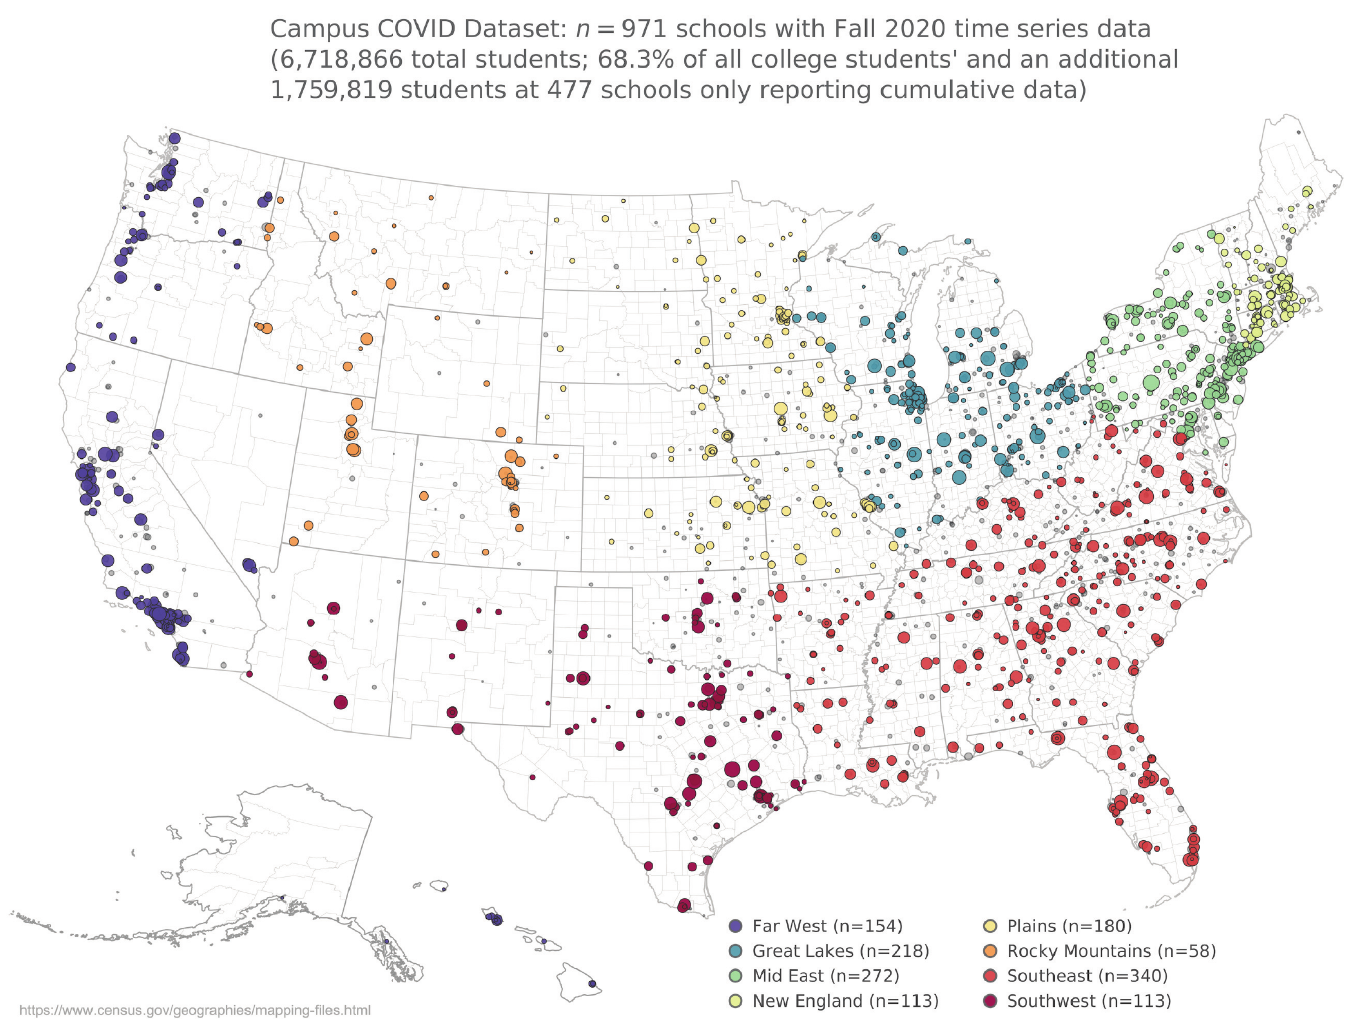
Fig 1. Description of the Campus COVID Dataset. Map of the 1,448 institutes of higher education included in the Campus COVID Dataset. The dataset includes semester-long time series for 971 institutes of higher education (see S1 Text for several examples), in addition to 477 that have cumulative data only (i.e. one sum for the total testing and/or case counts for the Fall 2020 semester). County and state boundary maps downloaded from the United States Census TIGER/Line Shapefiles [52].